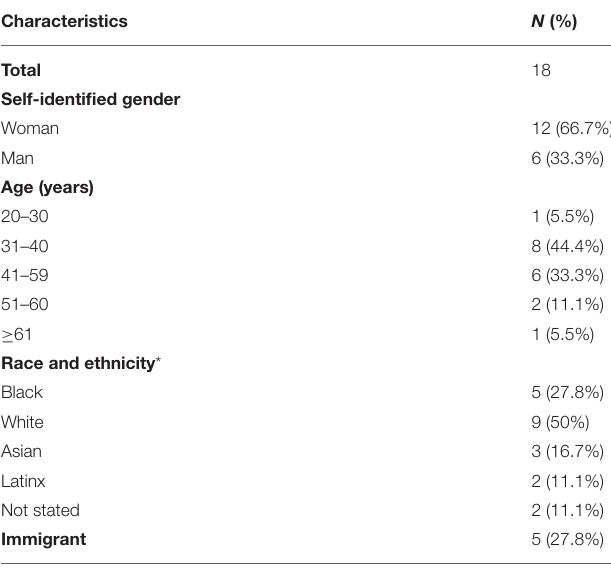
TABLE 1 | Demographics of